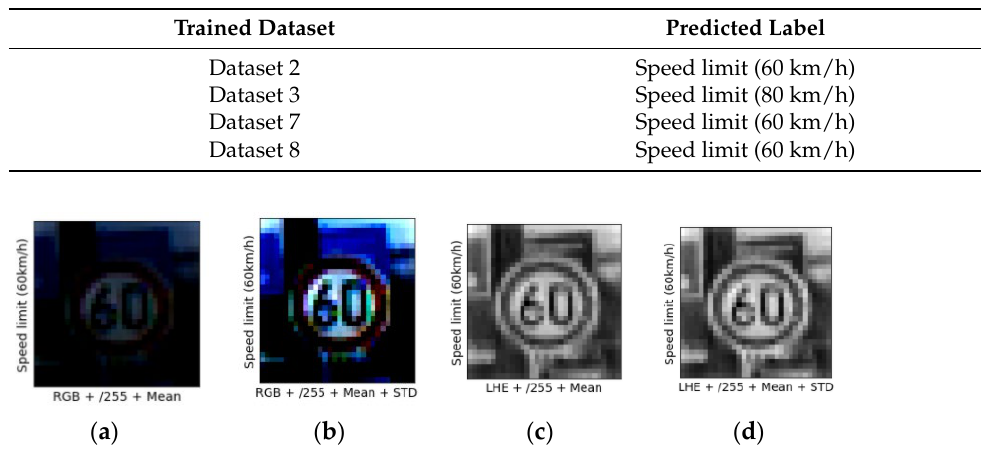
Figure 11. ( a ) RGB +/255 Mean 14 ( b ) RGB +/255 Mean + STD ( c ). LHE +/255 Mean and ( d ) LHE +/255 Mean +STD. Table 6. Comparison of datasets to predict an unknown dataset of different labels